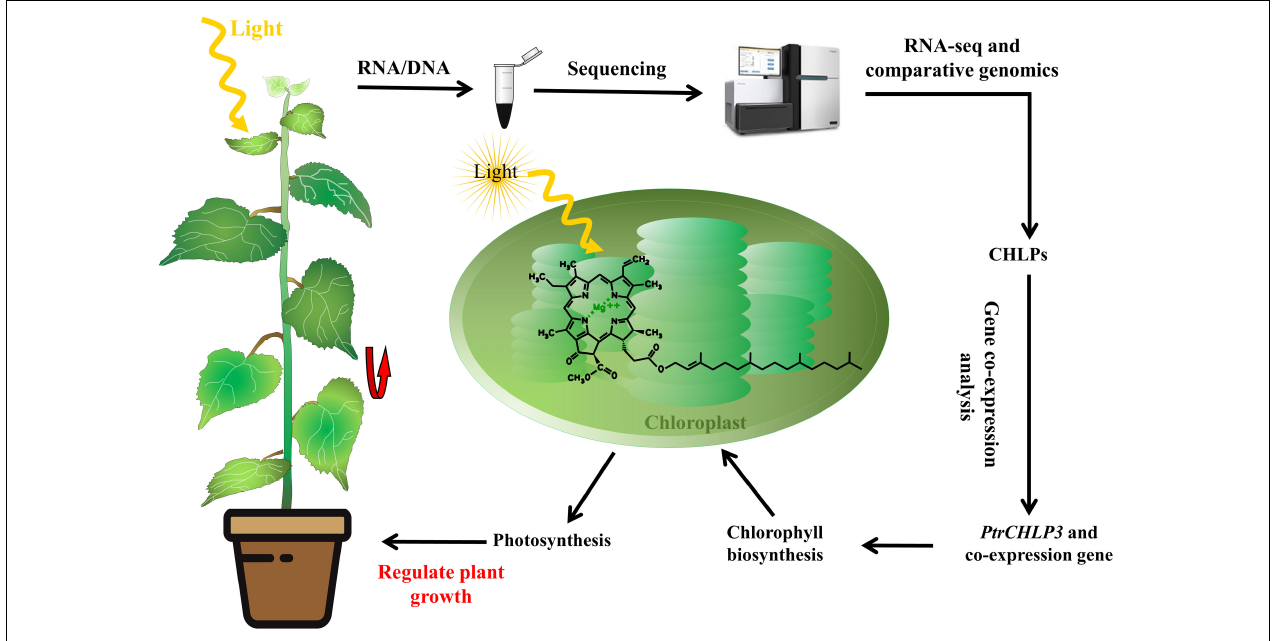
FIGURE 8 | An operation model for PtrCHLP3 regulation of poplar